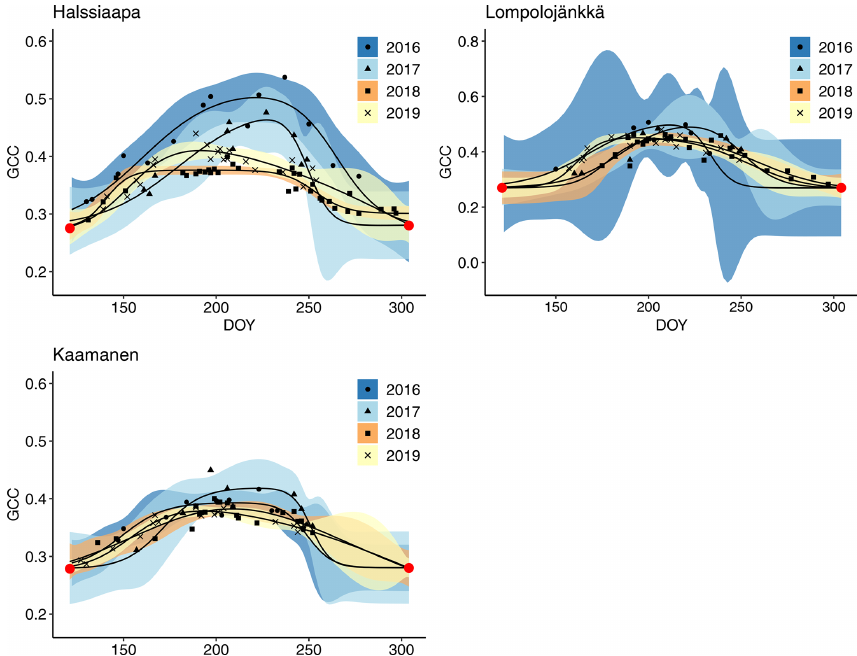
Figure 10. Mean GCC derived from the Sentinel-2 data from 1 May to 30 September in 2016–2019 at Halssiaapa, Lompolojänkkä and Kaamanen. Different symbols and colours denote different years, and the bands show the 95% confidence intervals of the fitted double hyperbolic tangent function. The red dots indicate the fixed start and end days defined for the fitting. Note the different y -axis scaling for